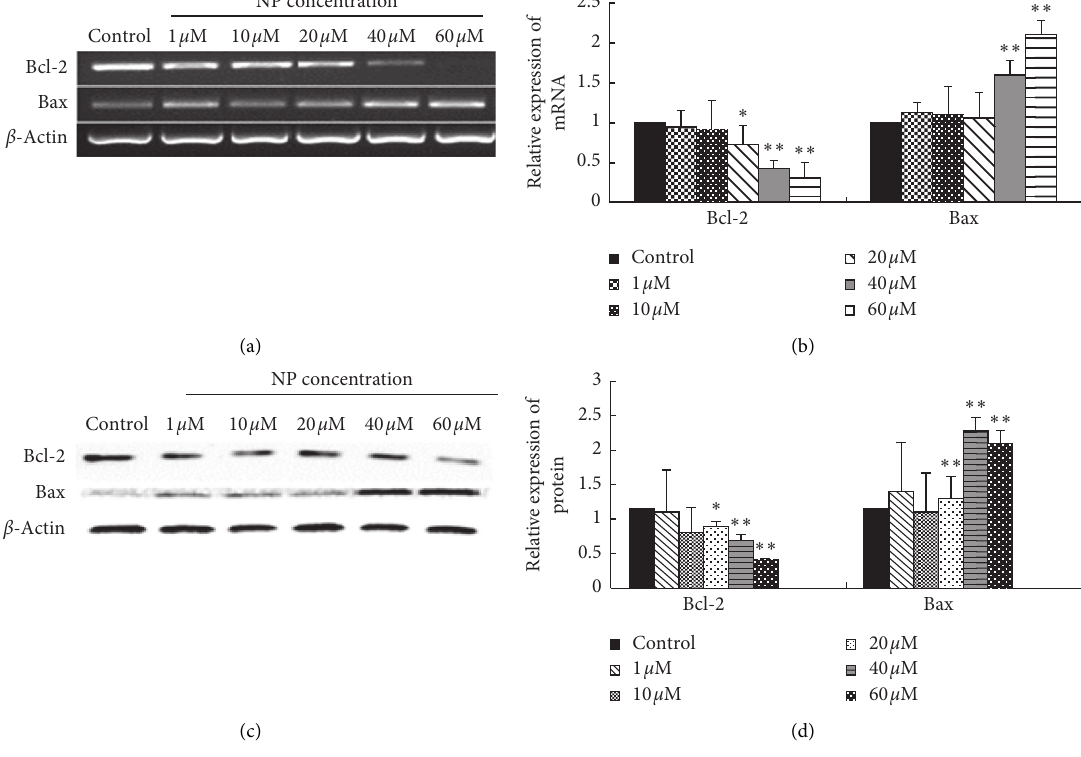
Figure 5: Protein and mRNA expression of Bax and Bal-2. (a) RT-PCR was performed for target genes and β -actin. (b) The histogram represents the quantification of Bax and Bcl-2 mRNA levels (levels of control cells/ β -actin defined as 1). (c) Western blot was performed for the target protein and β -actin. (d) The histogram represents the quantification of Bax and Bcl-2 protein levels (levels of control cells/ β -actin defined as 1). Results are presented as mean ± SD with triplicate measurement. ∗ P < 0 . 05, ∗∗ P < 0 . 01 versus the control